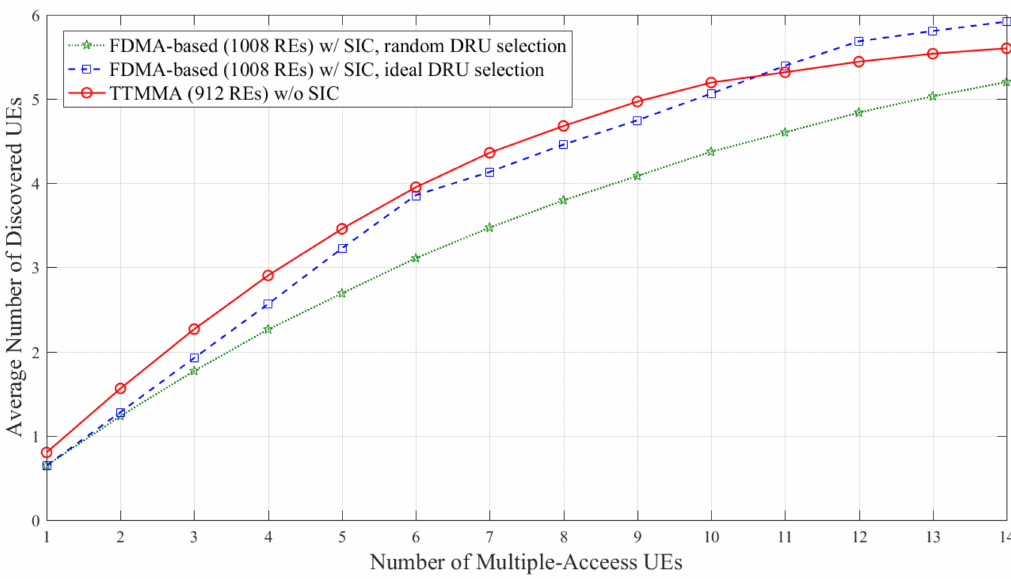
Figure 10. Average number of discovered UEs according to the number of multiple-access UEs in TDL-A channel with only applying SIC to FDMA-based scheme.